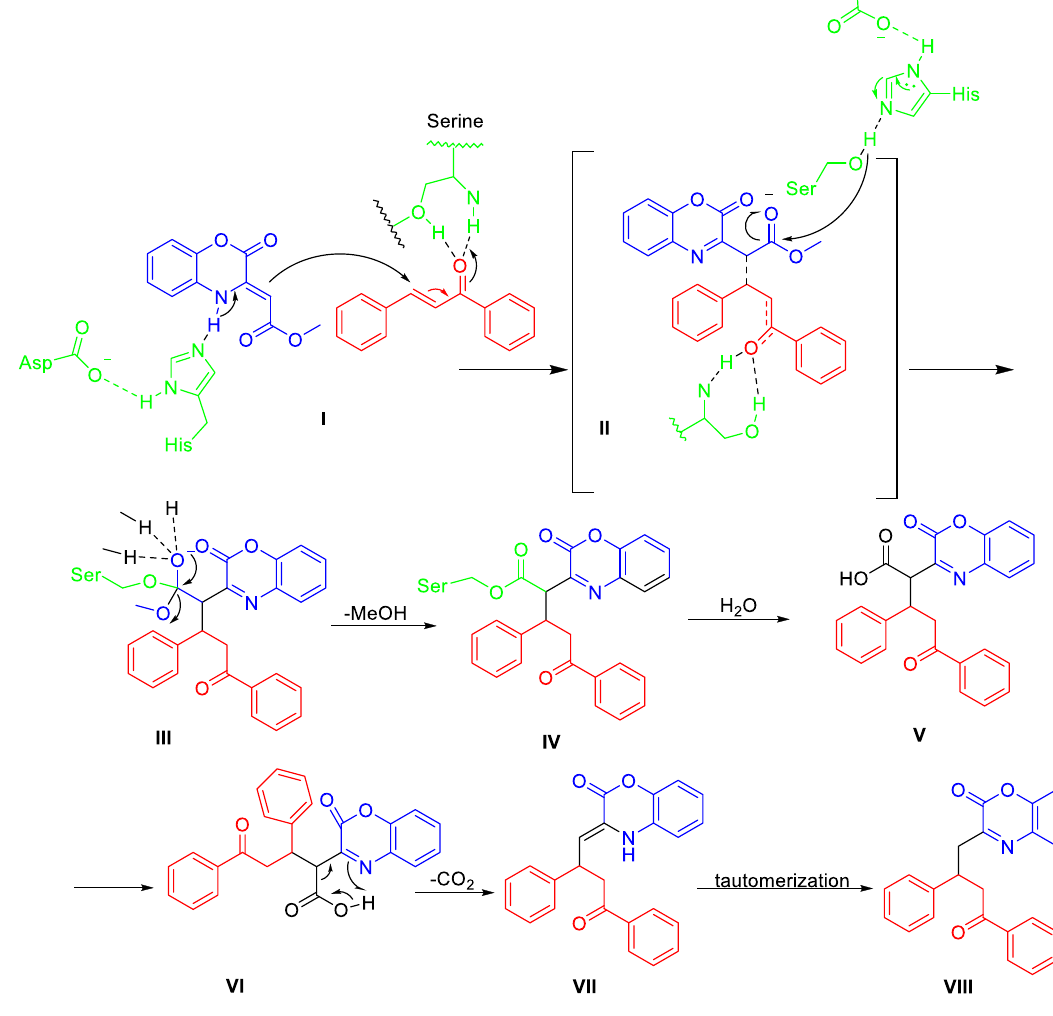
Figure 5. Suggested mechanism of decarboxylative Michael